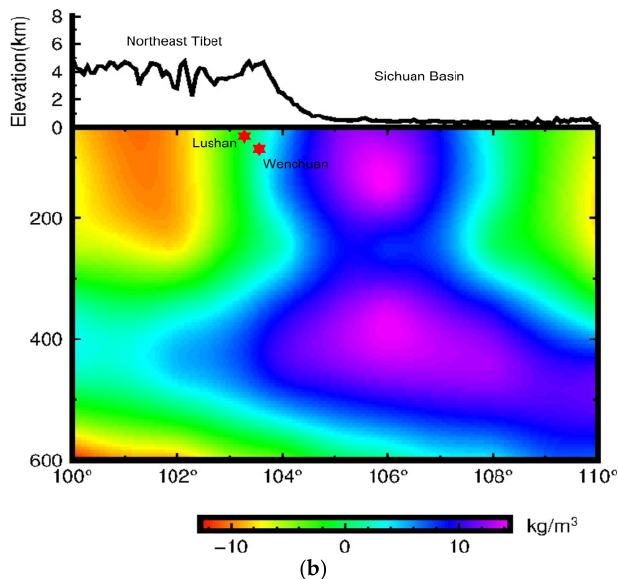
Figure 6. ( a ) Vertical density sections at latitude 25°N from longitude 90°E to 105°E; the black solid line is the elevation across the profile; the red star shows the location of the Yingjiang earthquake; and the red triangle shows the location of the Tengchong volcano. ( b ) Vertical density sections at the latitude 31°N from longitude 100°E to 110°E; the black solid line is the elevation across the profile and the red stars show the locations of the Lushan and Wenchuan earthquakes.